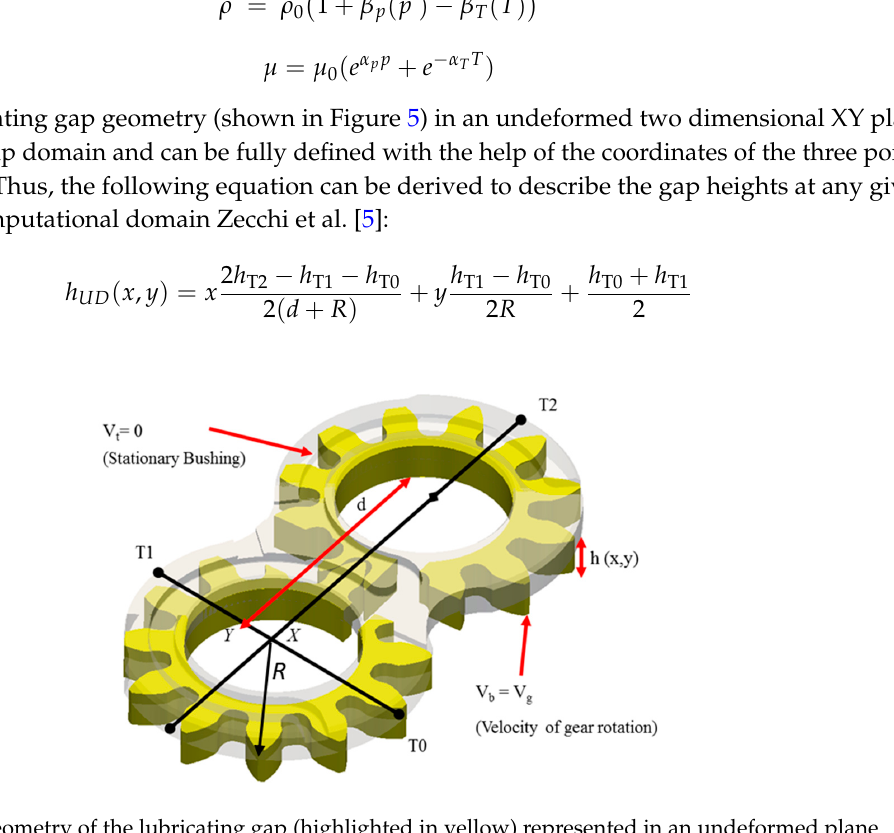
Figure 5. Geometry of the lubricating gap (highlighted in yellow) represented in an undeformed plane (Dhar and Vacca [8]).